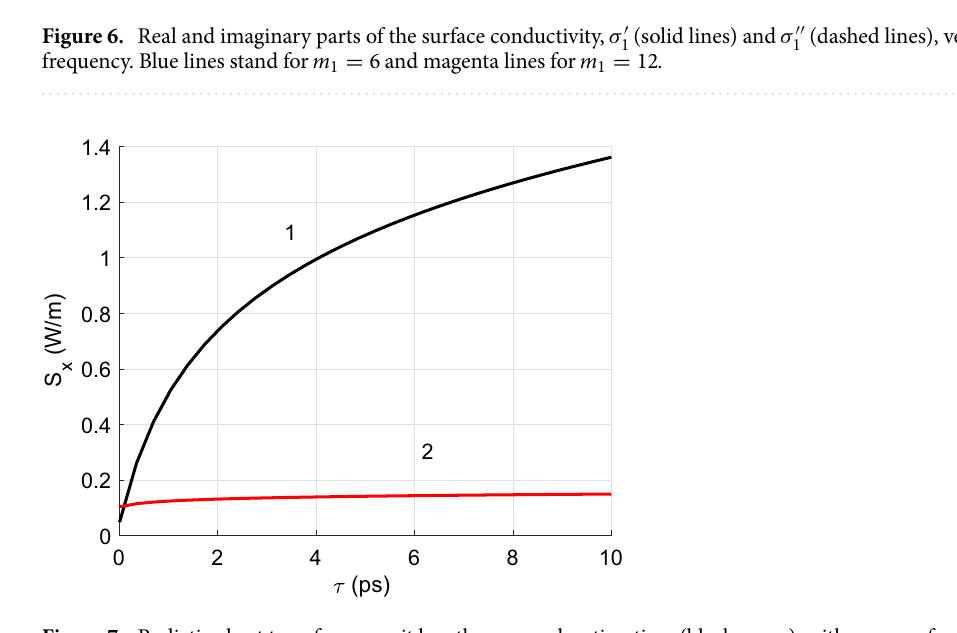
Figure 7. Radiative heat transfer per unit length versus relaxation time (black curve), with τ 1 zigzag CNTs with m 1